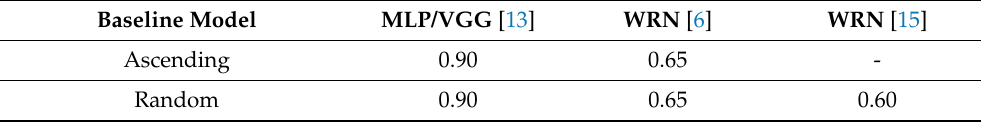
Table 5. Comparison of the performances of existing